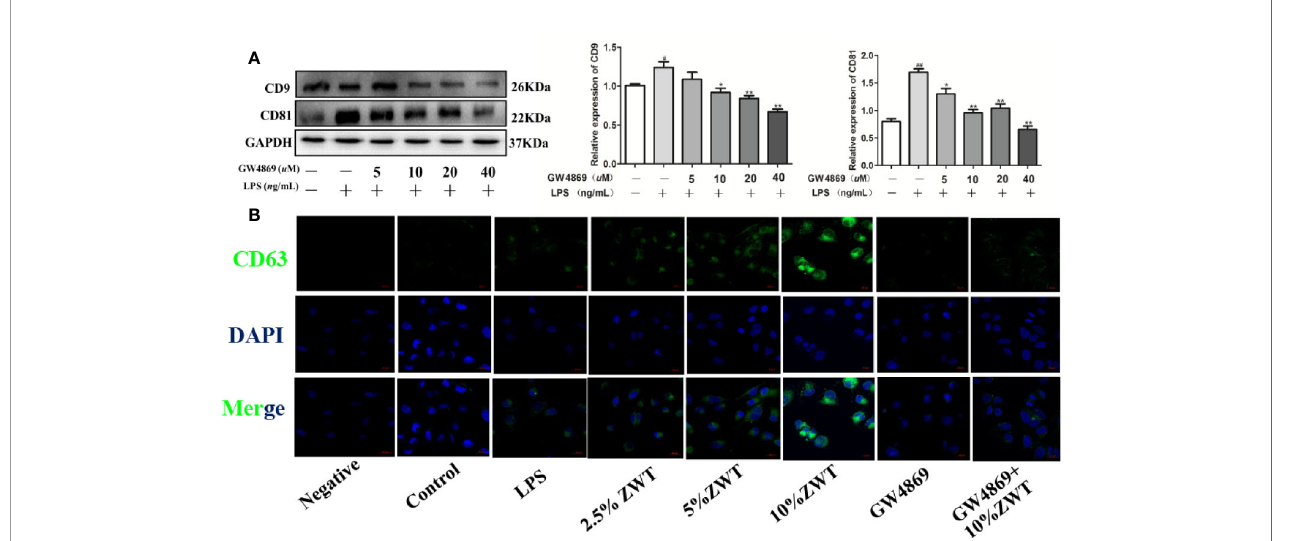
FIGURE 3 | GW4869 had a negative effect on the release of exosomes. (A) Exosomal protein levels in the supernatant of HK-2 cells after GW4869 treatment were analyzed by western blot, 40 m M was the optimal concentration to inhibit the expressions of CD9 and CD81 (n = 3). The statistical data of all the proteins were analyzed and transformed by ImageJ 1.8.0 112 software. Data were expressed as mean ± SD. # P < 0.05, ## P < 0.01, compared with control group; *P < 0.05, **P < 0.01, compared with lipopolysaccharide (LPS) group. (B) Confocal microscopic images of exosomes secreted from the HK-2 cells treated with or without LPS, ZWTS, and GW4869. Magni fi cation: ×200. Scale bar: 20 m m.